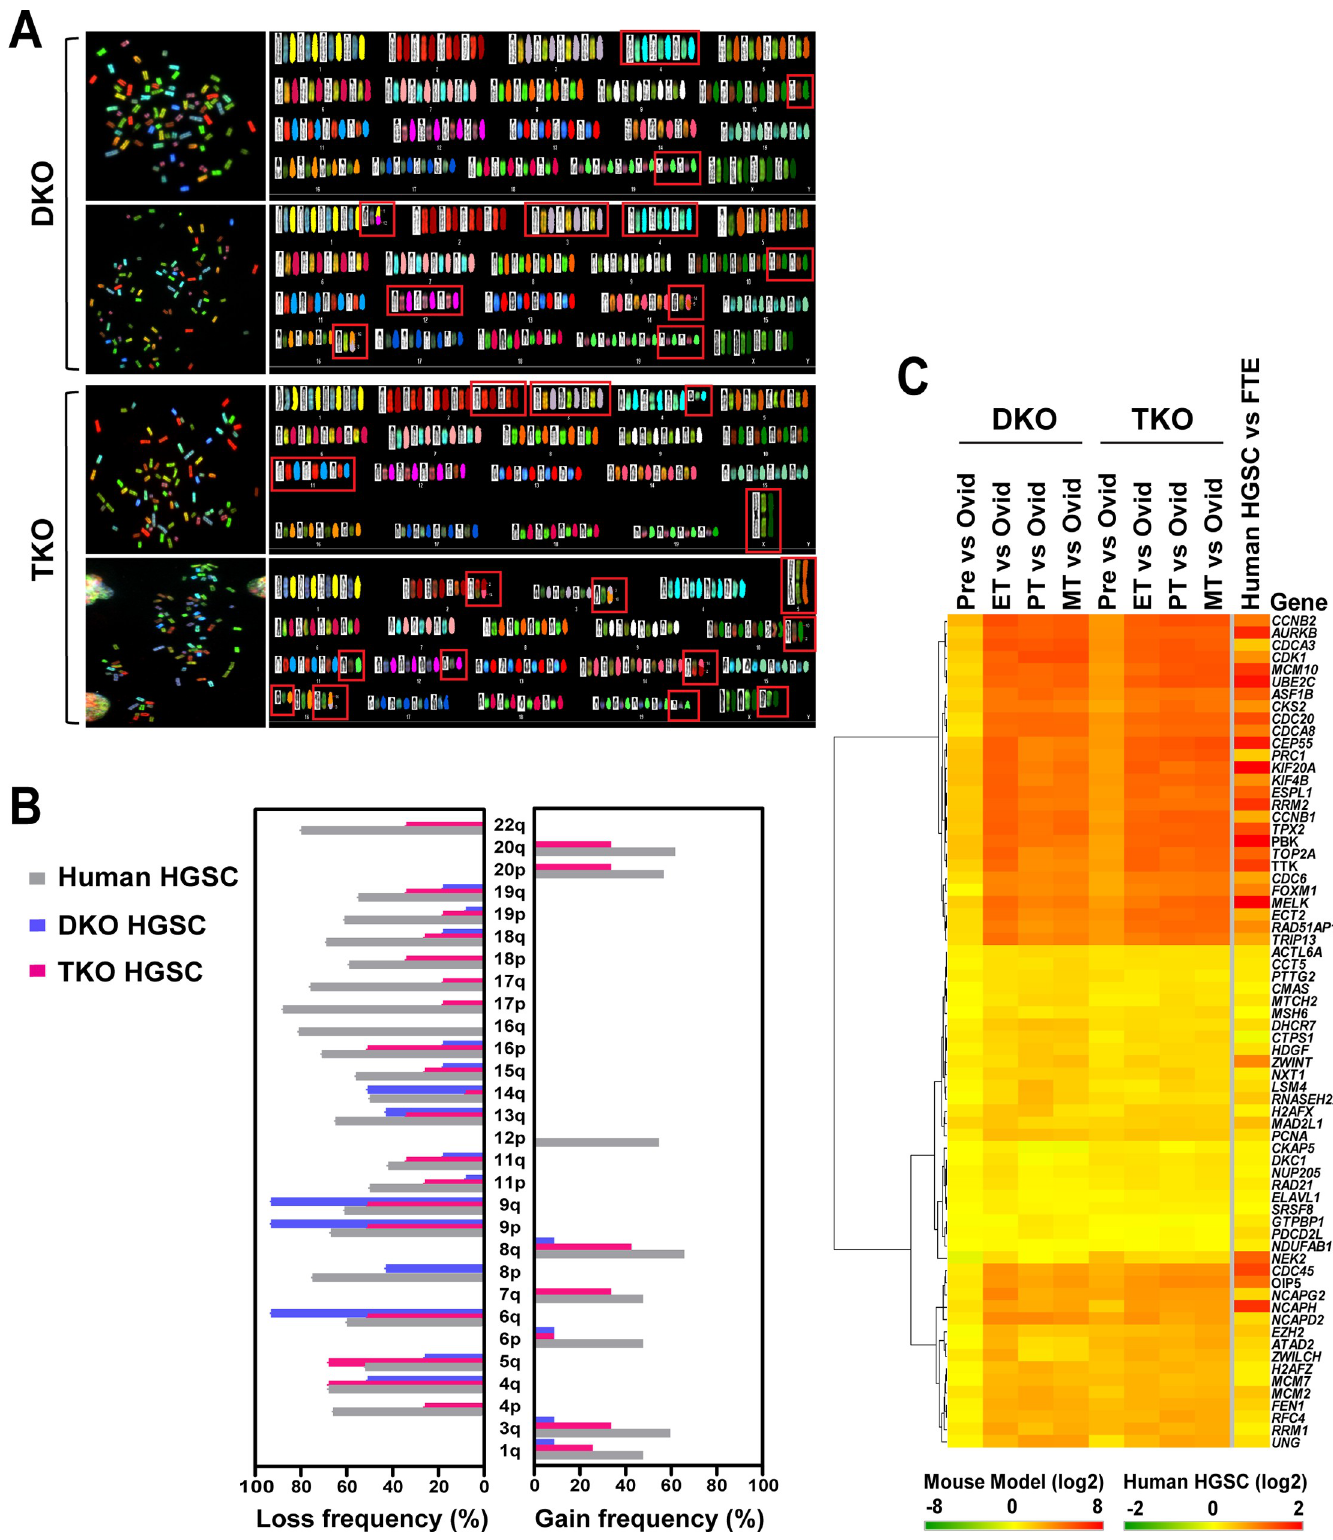
Fig 3. Marked chromosomal abnormalities and genomic instability in mouse and human HGSCs. A. Karyotype analysis of DKO and TKO cell lines by spectral karyotyping (SKY). Both DKO and TKO HGSC cells display abnormal near-tetraploid and aneuploid karyotypes. Numerical (chromosome gain/loss) and structural (translocation and deletion) alterations are marked in red boxes. Each chromosome is displayed as duplicated chromosomes at metaphase. Overall, TKO cells are represented by higher levels of karyotypic heterogeneity (differences among metaphase spreads within the same cell line), recurrent translocations, and unique chromosomal aberrations than DKO cells. B. Comparison of chromosome gains and losses between mouse and human HGSCs. There are substantial overlaps in PLOS Genetics | https://doi.org/10.1371/journal.pgen.1008808 June 4, 2020 8 /